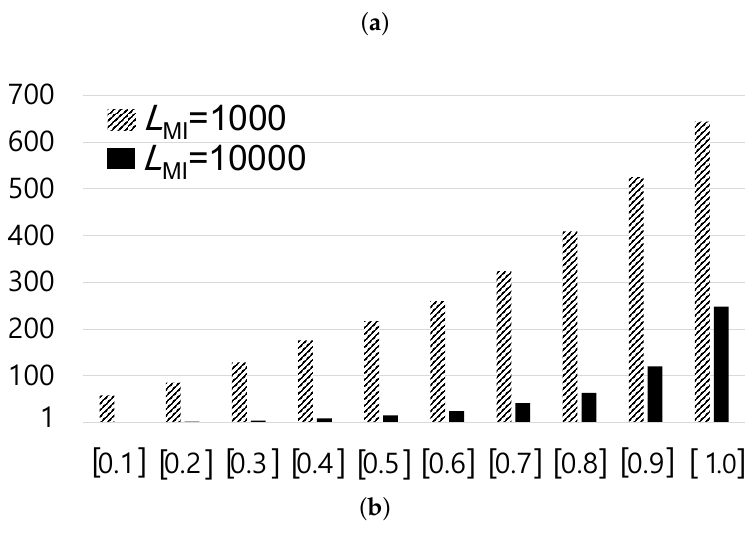
Figure 2. Inference accuracy of each task period under RM. ( a ) Average number of feasible choices of each task period and the ratio of exactly inferred task periods, over increasing L MI with [0.2]; ( b ) Average number of feasible choices of each task period, over varying use with L MI = 1000 and